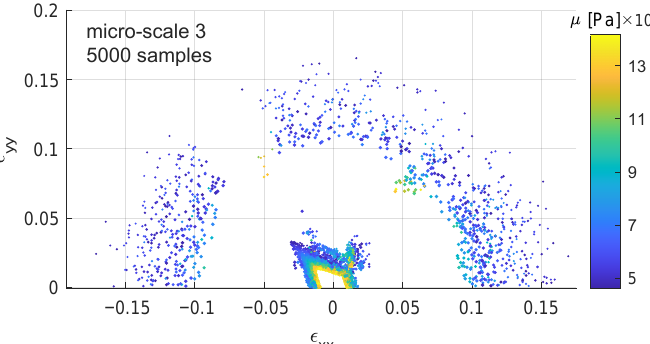
Figure 8. Failure points in the xx – yy strain space. Colorbar represents µ coefficient in the range [480–1442] 10 6 Pa and the diameter of the dots the tolerance threshold [0.0010–0.0001]. File available × in the supplementary materials.